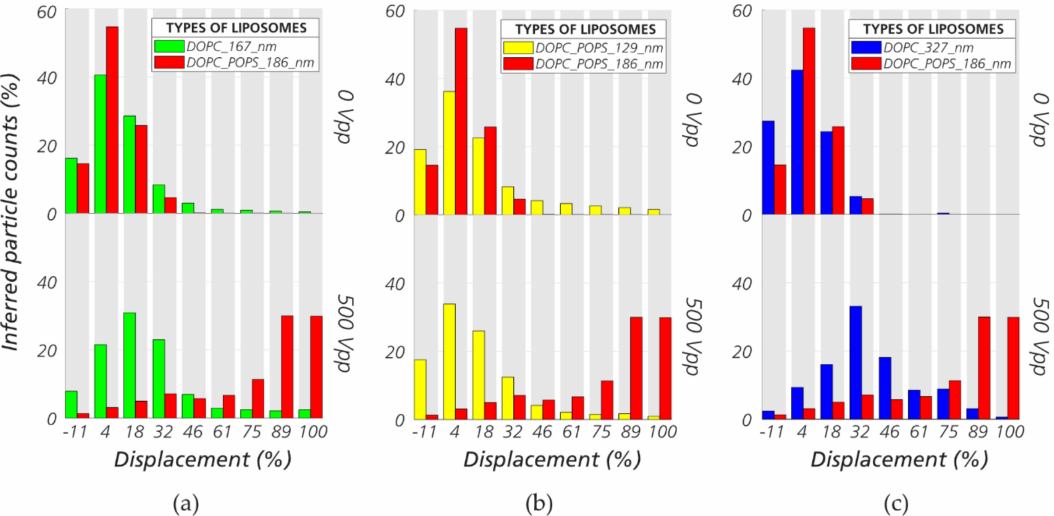
Figure 7. Sorting nano liposomes in eDLD. In general, the 1,2-dioleoyl-sn-glycero-3-phosphocholine (DOPC) liposomes possess lower charge than the DOPC + 10%POPS liposomes. ( a ) Separation of liposomes of similar sizes but di ff erent surface properties ( ζ DOPC,167nm = − 10 mV, = − 67 mV). The higher charged DOPC / 1-palmitoyl-2-oleoyl-sn-glycero-3- ζ DOPC + 10%POPS,186nm phospho-L-serine (POPS) liposomes are more displaced. ( b ) Liposomes of di ff erent sizes but similar surface properties ( ζ DOPC + 10%POPS,129nm = − 50 mV, ζ DOPC + 10%POPS,186nm = − 67 mV). The larger liposomes are more displaced. ( c ) Large liposomes with lower zeta potential ( ζ DOPC,327nm = − 16 mV) versus small liposomes with higher zeta potential ( ζ DOPC + 10%POPS,186nm = − 67 mV). In this case, the zeta potential is shown to be more important for the outcome of the sorting than the particle size. More information about size and zeta potential of liposomes can be found in Table S3 of the Supplementary Information. Device #1 ( D C = 0.66 µ m). Frequency: 1 kHz. Medium: KCl 2 mM ( σ = 29 mS /